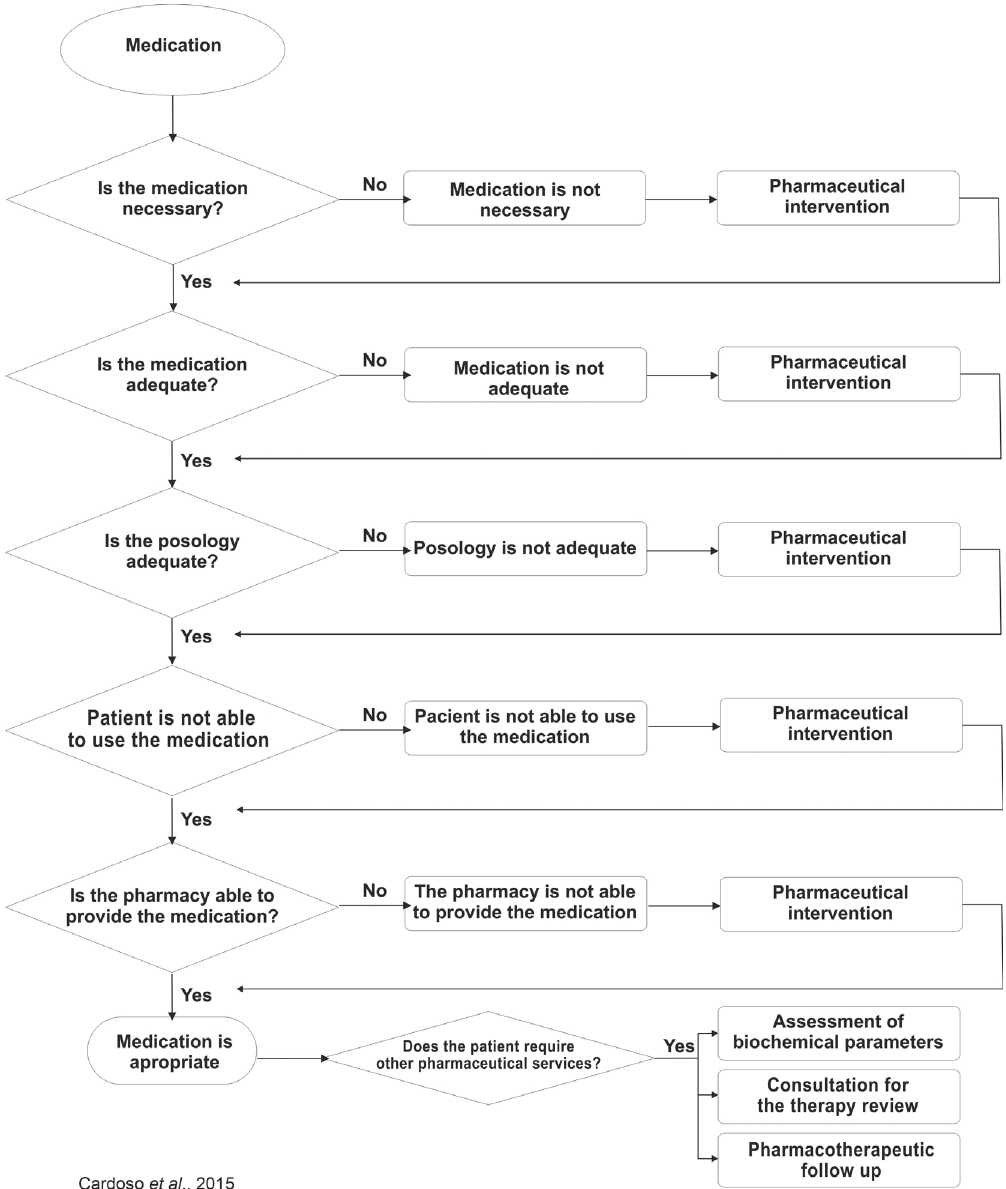
FIGURE 2 – Flowchart of the pharmacotherapy analysis at the Campus